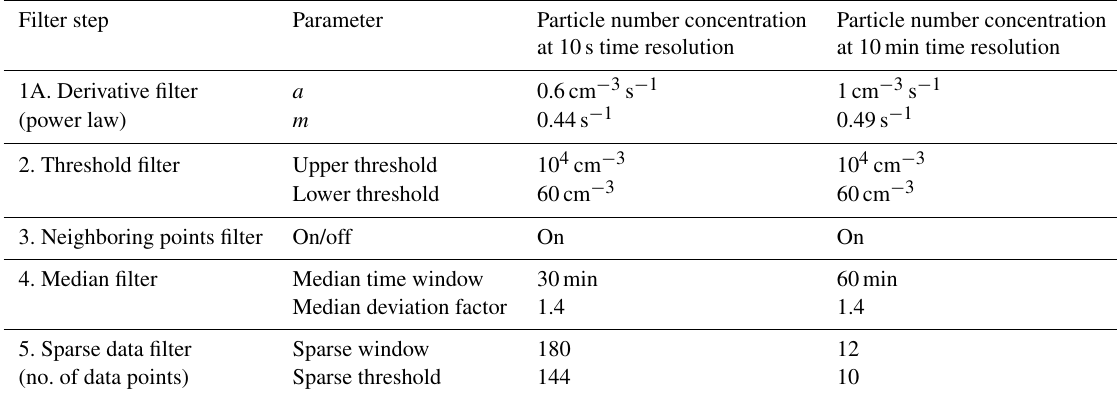
Table C1. Parameters used for the application of the PDA to two datasets with different time resolutions. Filter